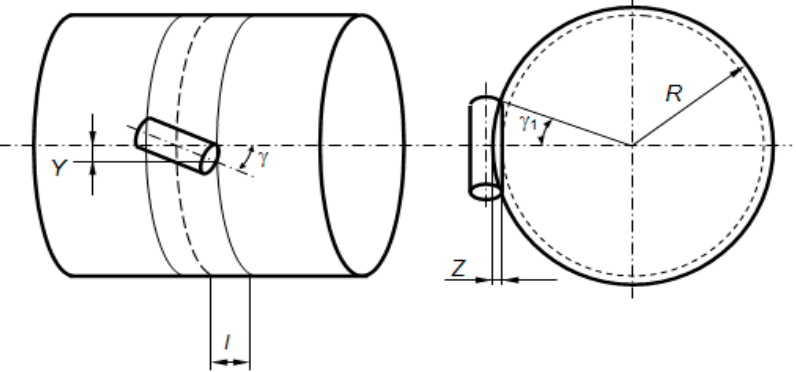
Figure 1. Wide burnishing geometrical parameters.